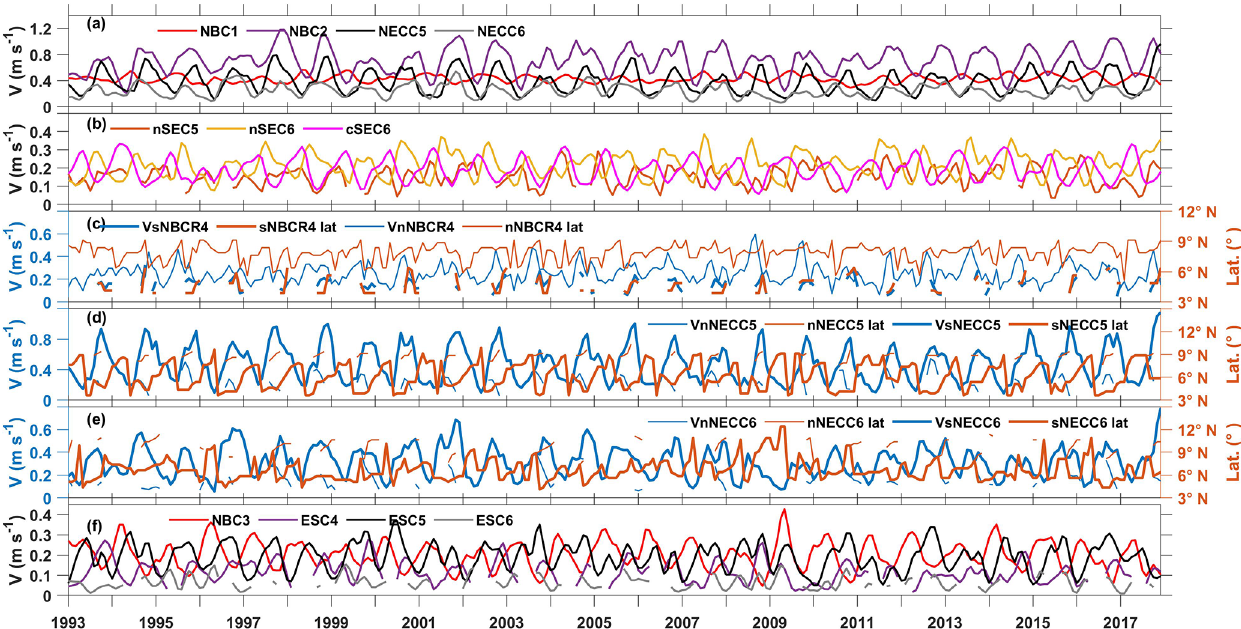
Figure 6. Time series of the 4-month low-pass-filtered characteristics of the geostrophic currents (a–f) captured along HS1 to HS6. Acronyms are listed in Table 1, and the numbers next to the acronyms represent the number of the horizontal sections. (a) Intensity of NBC1, NBC2, NECC5, and NECC6. (b) Intensity of cSEC6, nSEC5, and nSEC6. Panels (c) , (d) , and (e) show the core velocities and the locations of the nNBCR4 and the sNBCR4 flows; the nNECC5 and the sNECC5 flows; and the nNECC6 and the sNECC6 flows, respectively. (f) Intensity of the NBC3, ESC4, ESC5, and ESC6